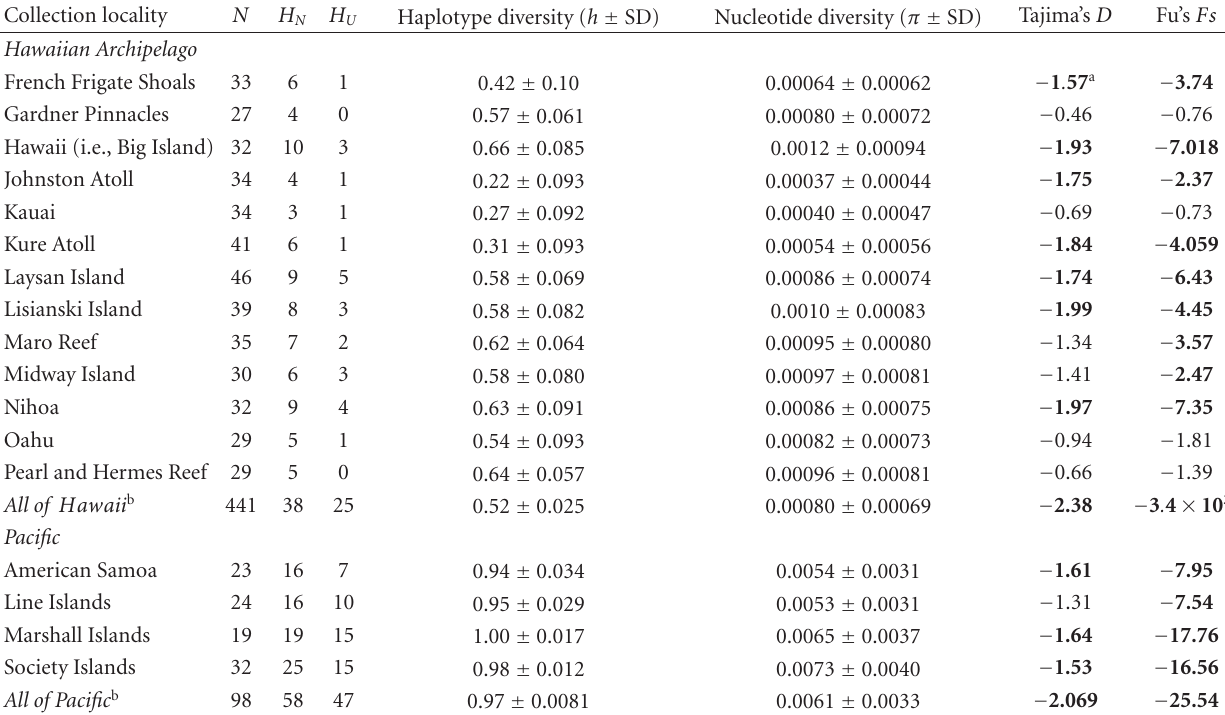
Table 1: Sample size and molecular diversity indices for the studied Acanthurus nigroris .